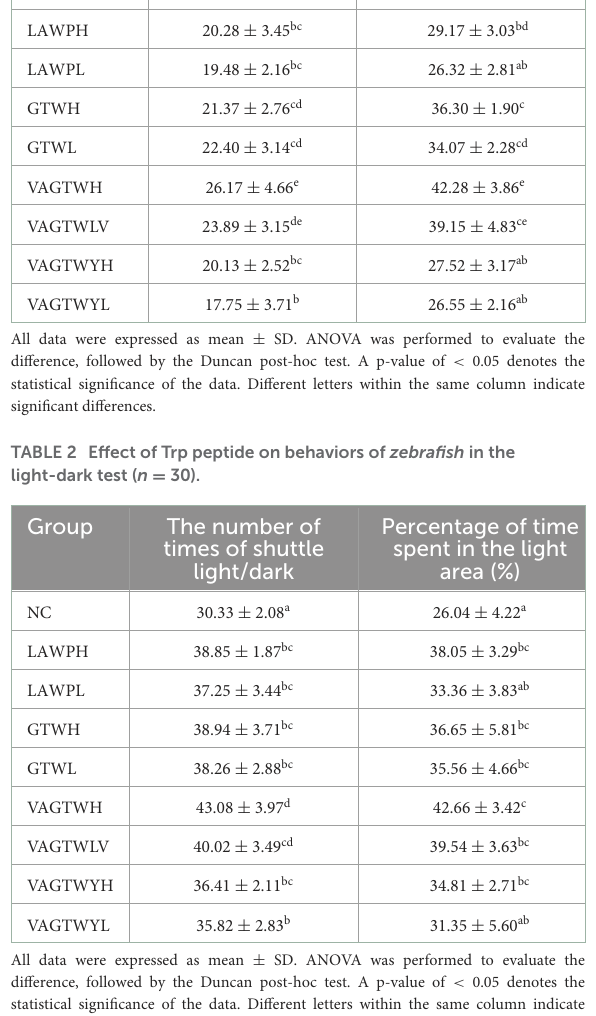
TABLE 1 Effect of Trp peptide on behaviors of zebrafish in novel fish tank test ( n = 30). Group The number of Percentage of times of shuttle retention time in the up/down top half of the tank (%)